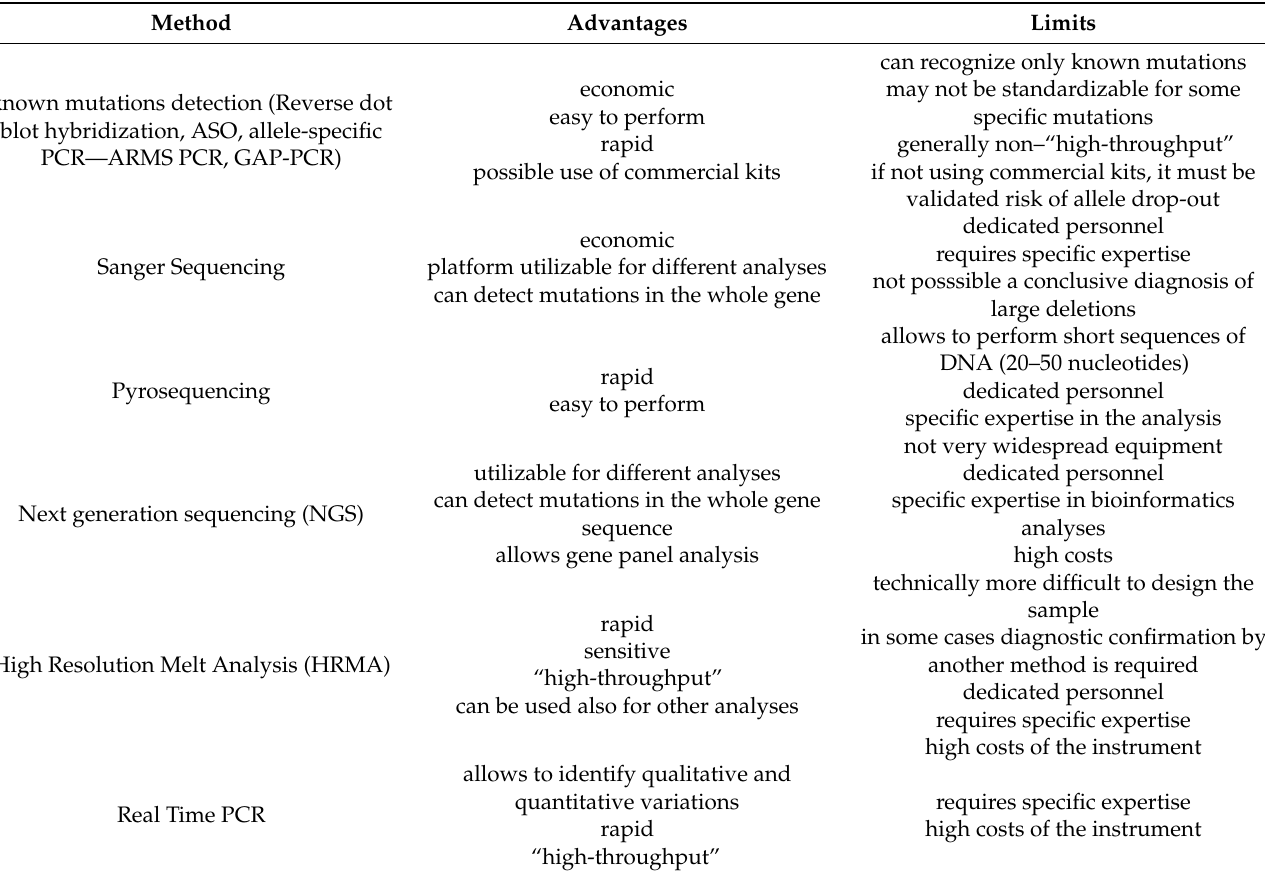
Table 10. Advantages and disadvantages of different techniques of DNA analysis